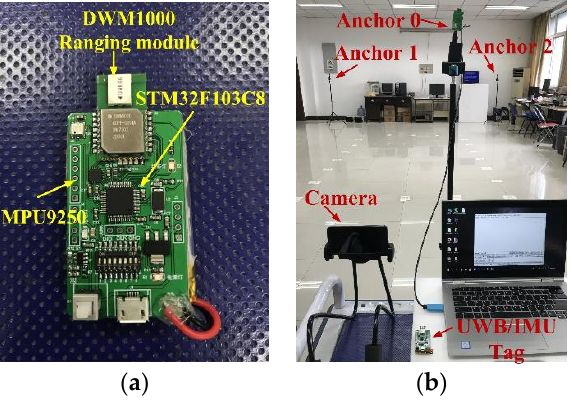
Figure 12. The setup for the experiment in test field. ( a ) The carried tag; ( b ) the setup for the test indoor positioning system.